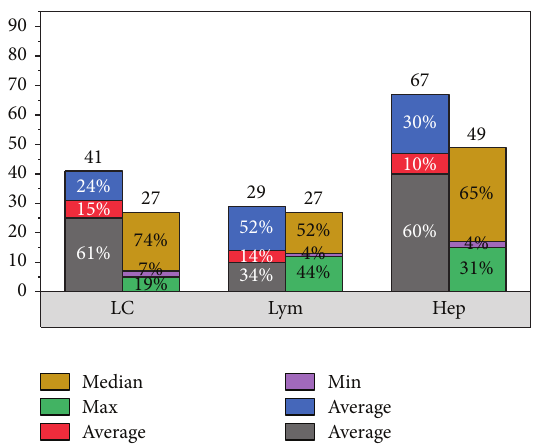
Figure 7: Distances obtained by the neighborhood granulation